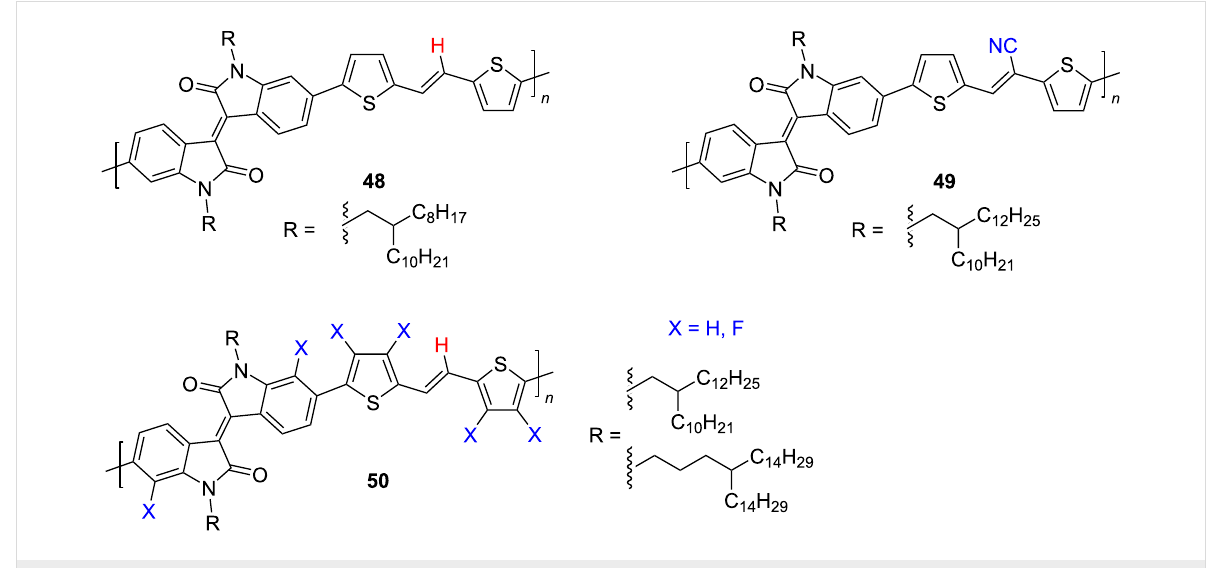
Scheme 25: Fluorination as a tool to improve isoindigo-based OFET devices.